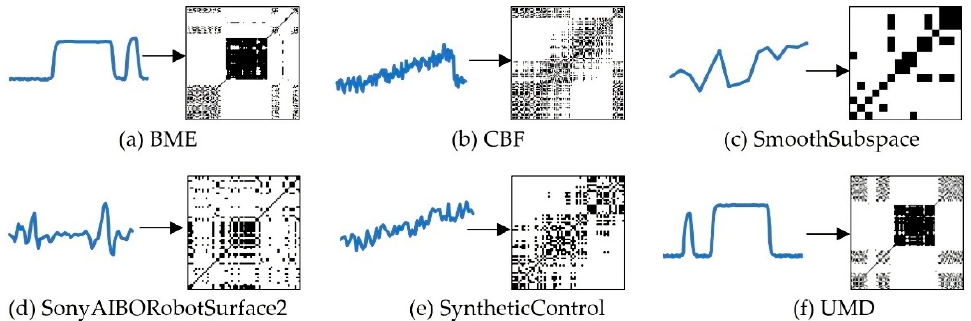
Figure 3. The effect of converting time-series into Recurrence Plot. The RP images clearly show the changes of different datasets through the arrange- ment of black and white blocks. For example, the SyntheticControl dataset generally pre- sents a drift trend. The RP images of the UMD appear in large black areas and show a mutation mode, which is caused by the rapid change of